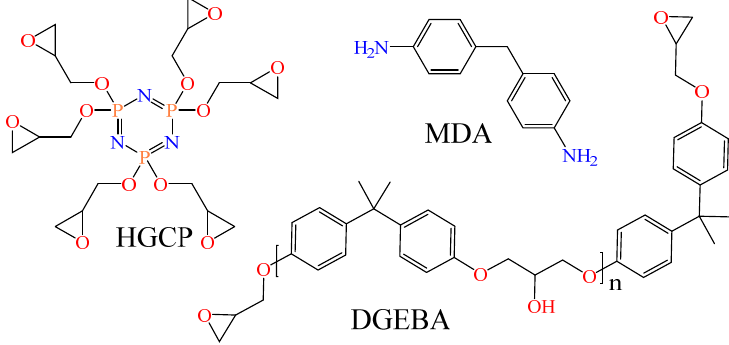
Figure 1. The study’s main elements of the epoxy composite materials.